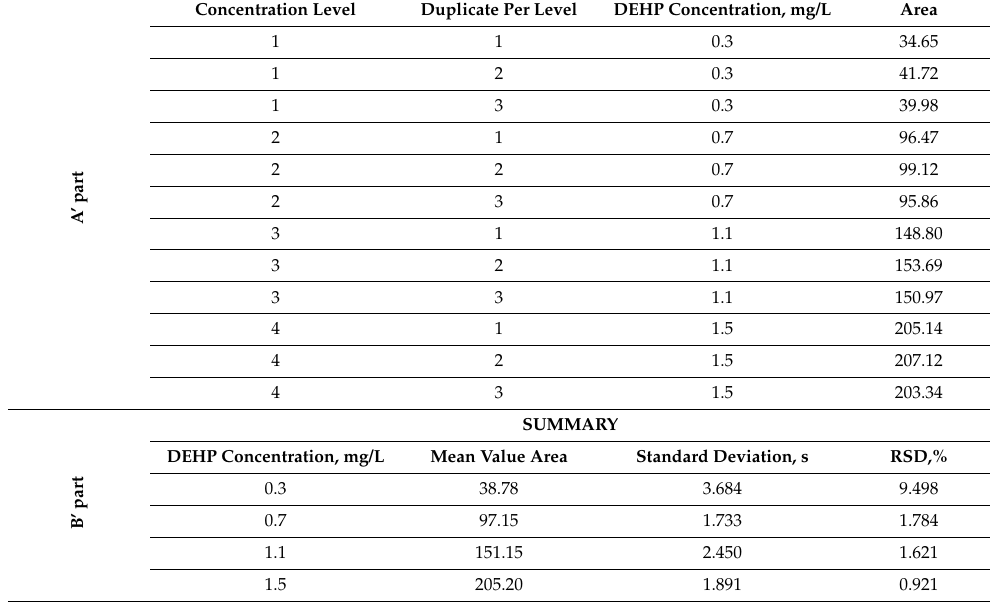
Table 3. Results of measurements to estimate the linearity of the method.